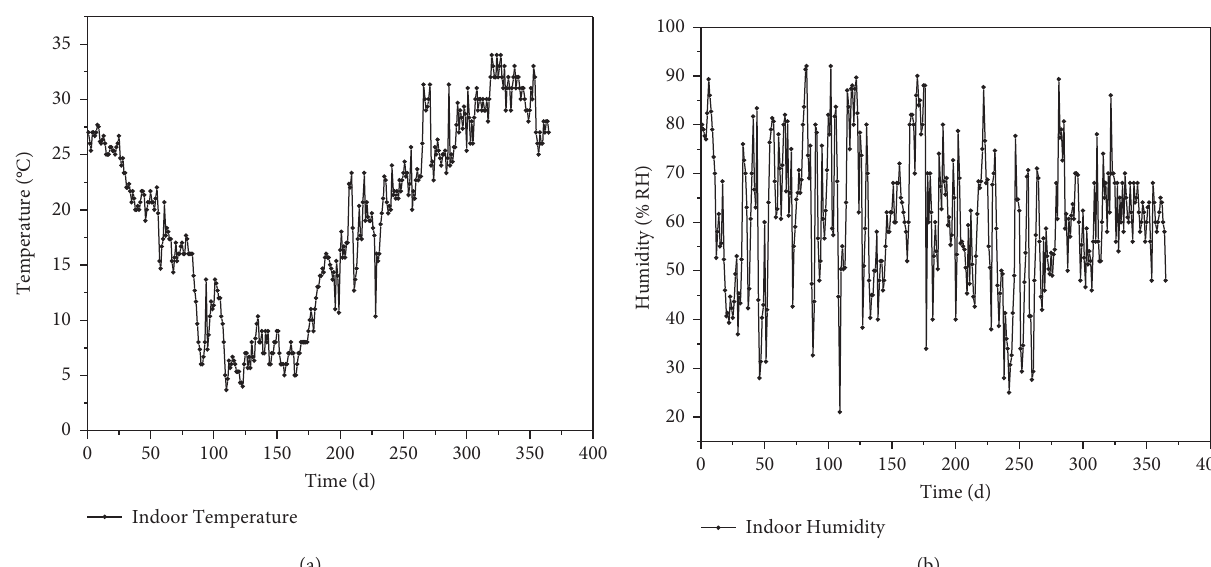
Figure 12: (a) Indoor temperature and (b) indoor humidity change curves with